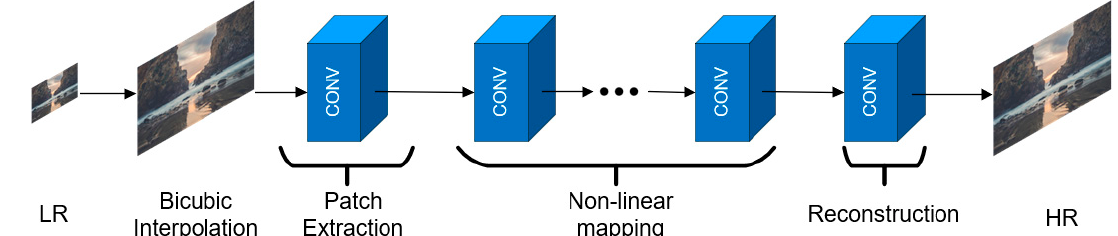
Figure 2. SRCNN network structure (LR stands for low-resolution, HR stands for high-resolution).